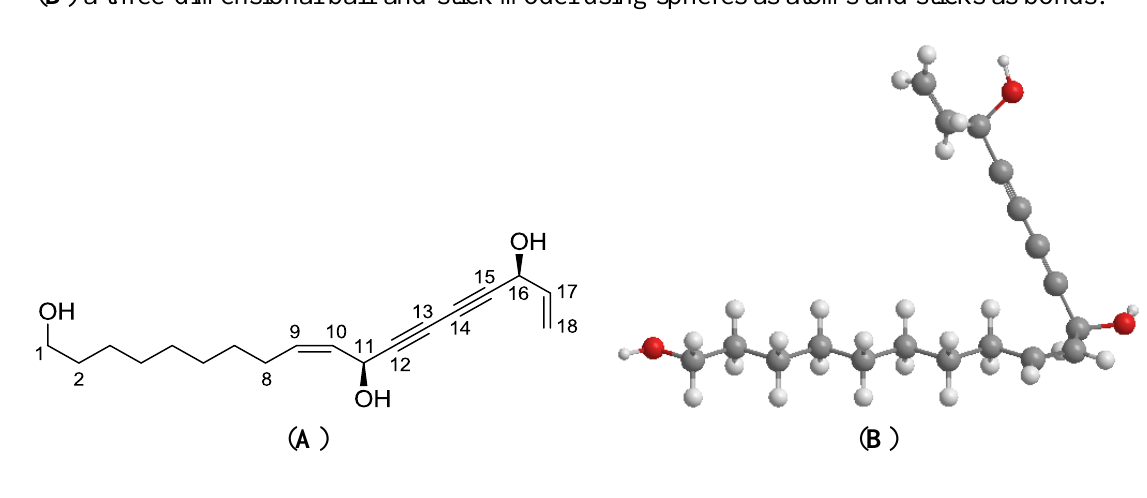
Figure 1. Structure models of oplopantriol A. ( A ) A two-dimensional structural formula; ( B ) a three-dimensional ball-and-stick model using spheres as atoms and sticks as